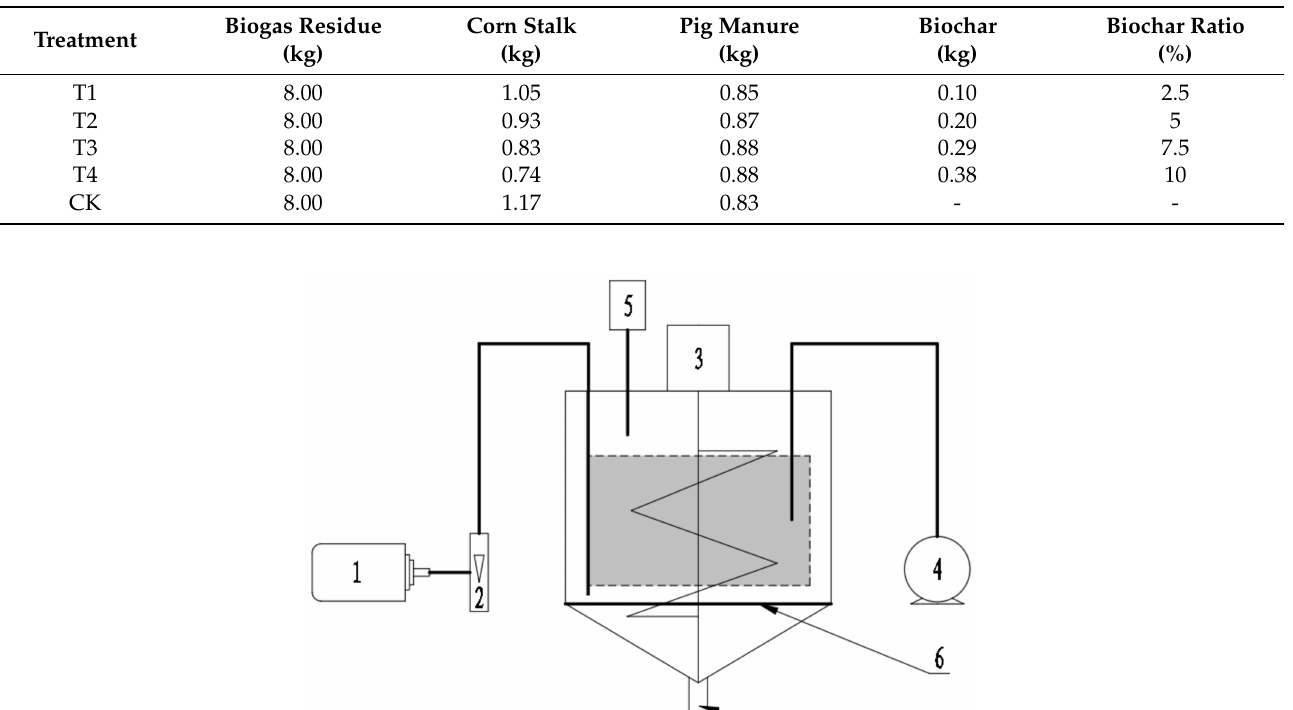
Table 2. Amount of composting materials added in each treatment.